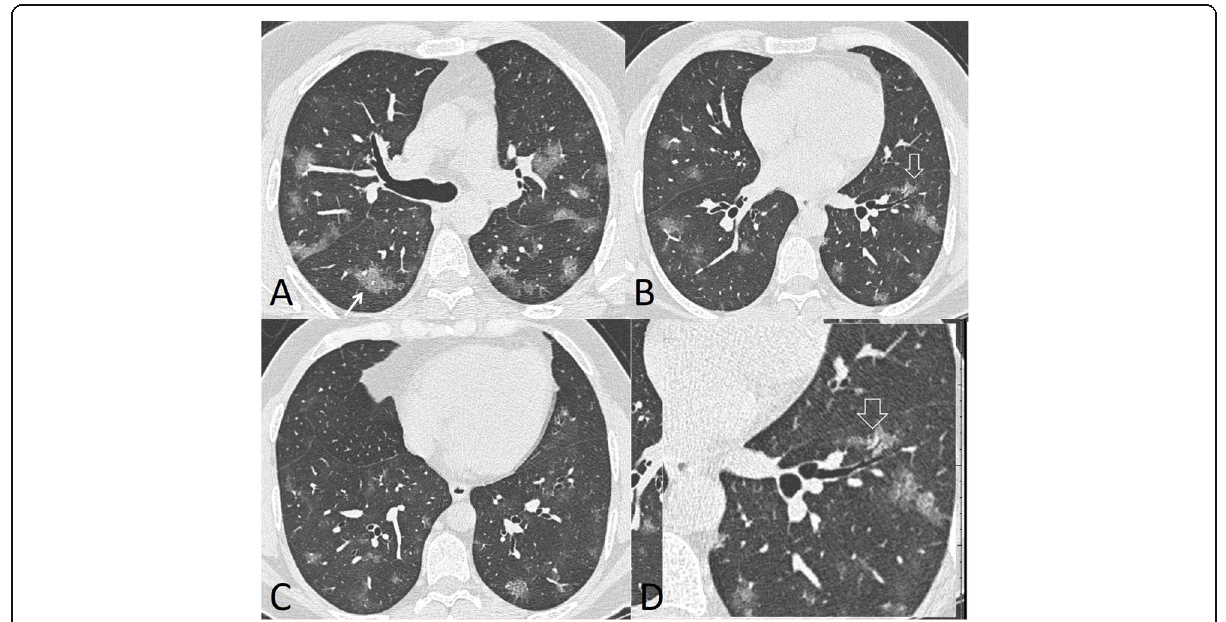
Fig. 2 A 46-year-old male patient with bilateral multiple ground glass opacities (white arrow in a ) and air bronchogram (hollow arrows in b and c ). Total severity score =